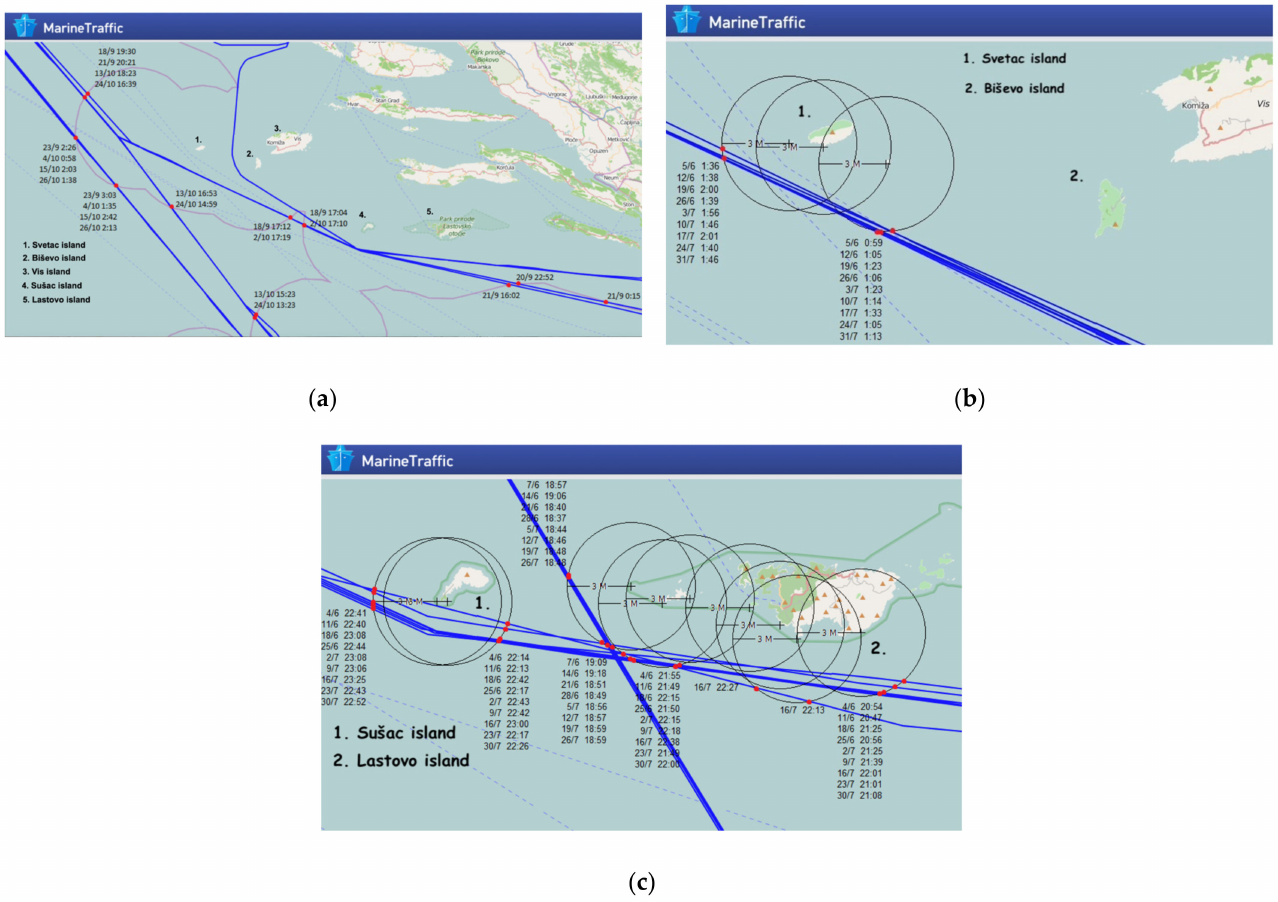
Figure 8. ( a ) Presentation of cruise traffic distance from the islands’ shores and display of >12 M retention calculation in the central and south Adriatic east coast; ( b ) presentation of cruise traffic distance from the islands’ shore and display of >3 M retention calculation with focus on the islands of Svetac and Biševo; ( c ) presentation of cruise traffic distance from the islands’ shores and display of >3 M retention calculation with focus on the islands of Sušac and